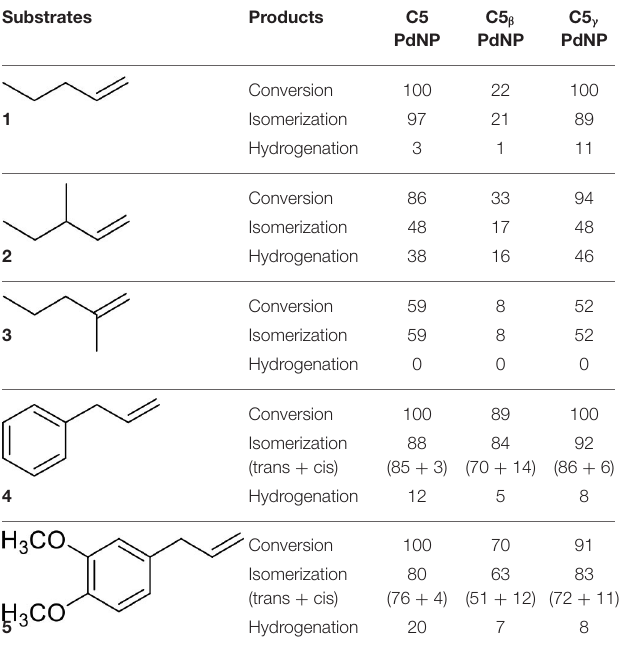
TABLE 2 | The catalysis results for pentene and allylbenzene derivatives by colloidal Pd nanoparticles a .